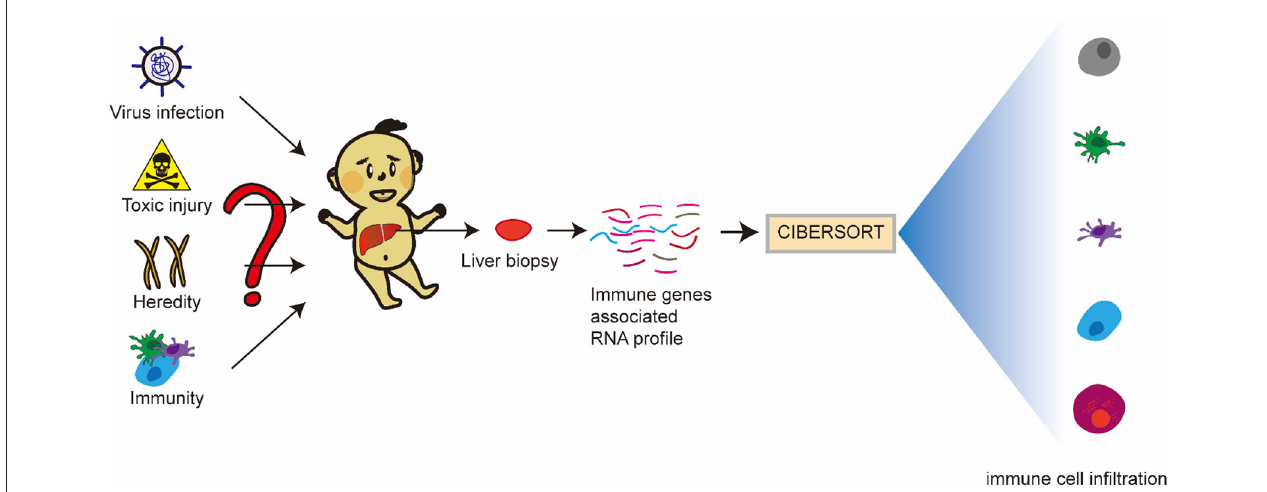
FIGURE 13 | Article hypothesis and ideas. BA may be an immune-related disease mediated by viral infection, toxic injury, and genetics, or even an autoimmune disease. Inherent and specific immunity play an important role in the occurrence and development of BA. DE-IGs in BA livers, normal livers, and hepatitis B livers were analyzed, and the proportion of 22 immune cells in all samples of the dataset was predicted using CIBERSORT software to elucidate the pathogenesis of